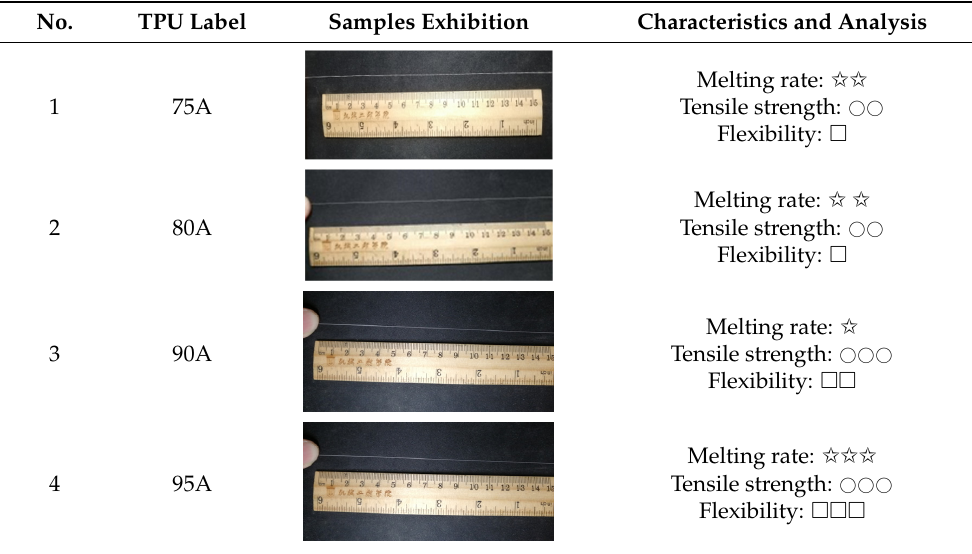
Table 3 demonstrates the performance effects of the different feed speeds of screws